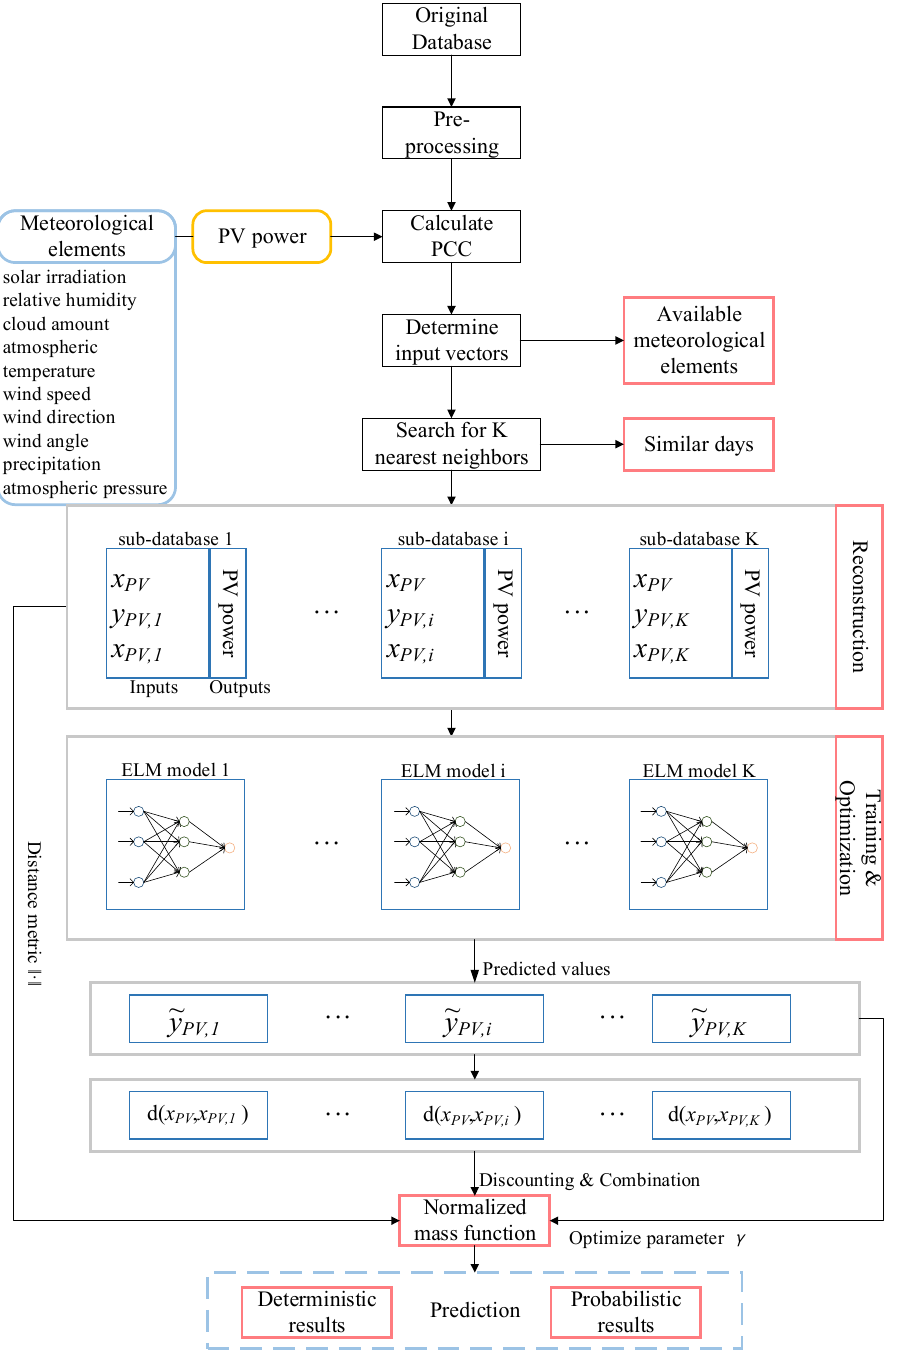
Figure 4. Schematic diagram of EELM in PV power forecasting.